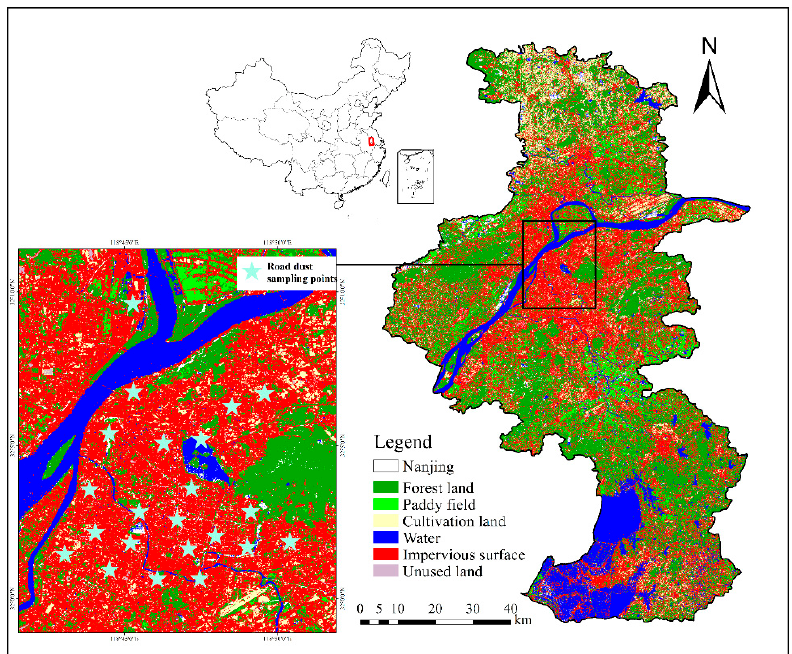
Figure 2. The model domain and assessed study area.